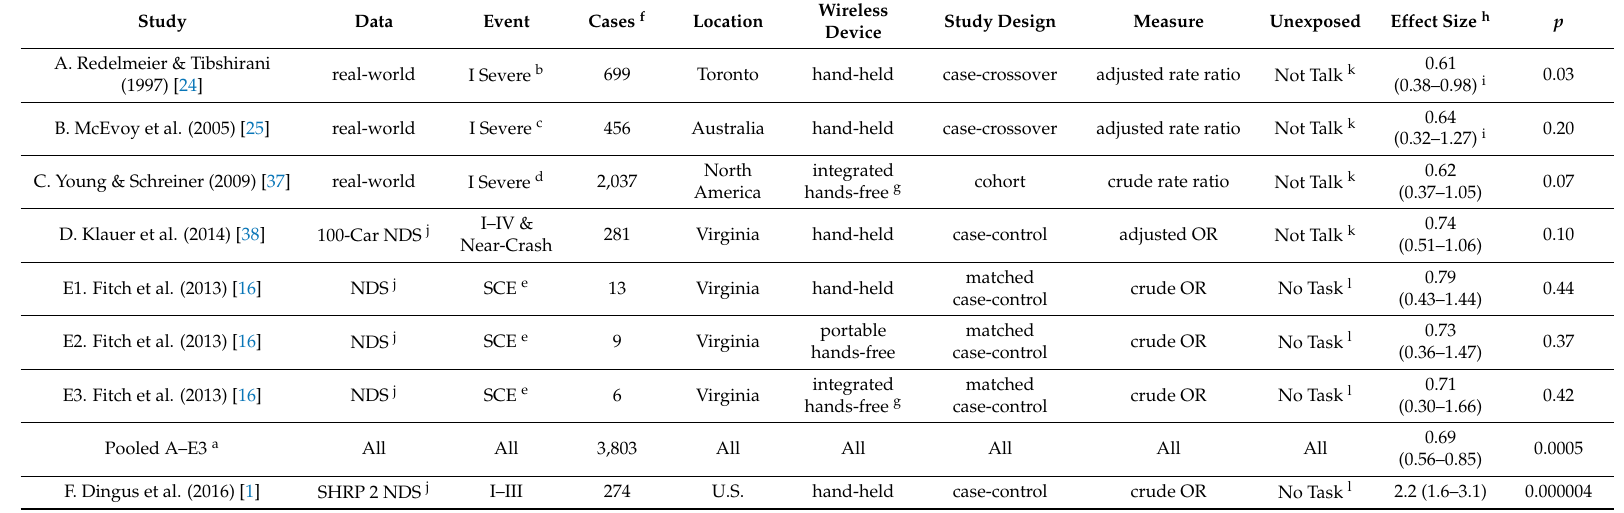
Table A1. Studies of wireless cellular conversation (“Talk”) while driving a passenger